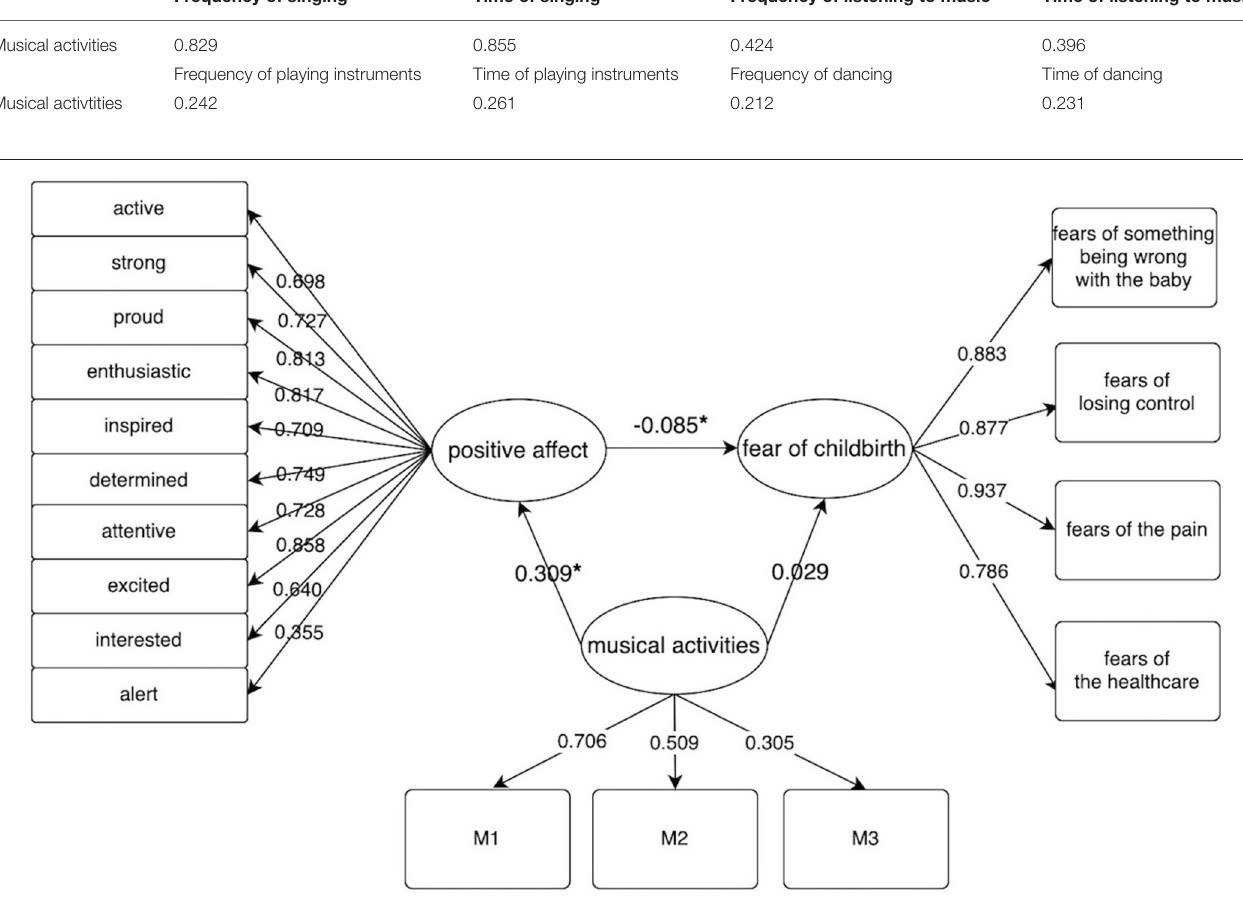
FIGURE 1 | Overall structural model. Standardized path coefficients are presented. *stands for P < 0.05. SRMR (Standardized Root Mean Square Residual) = 0.048, RMSEA (Root Mean Square Error of Bayesian) = 0.063, CFI (Comparative Fit Index) = 0.950, TLI (Tucker-Lewis Index) = 0.941, chi-square/df ratio = 597.688/116 = 5.152.M1 = FOS (Frequency of singing) + TOS (Time of singing); M2 = FLM (Frequency of listening to music) + TLM (Time of listening to music); M3 = FPI (Frequency of playing instruments) + TPI (Time of playing instruments) + FOD (Frequency of dancing) + TOD (Time of dancing); Indirect effect: − 0.026 ( P = 0.030), total effect = 0.003 ( P =